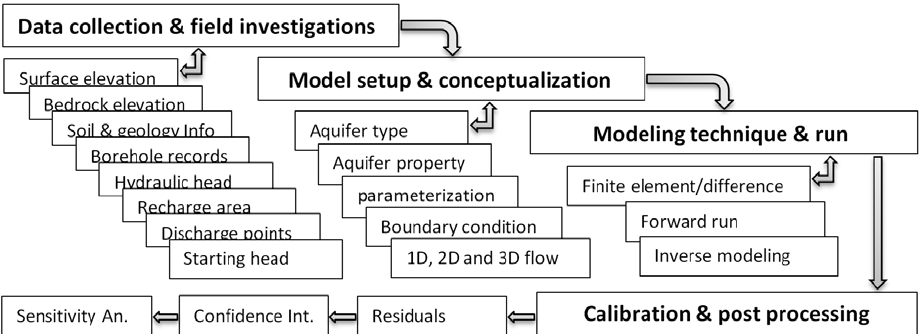
Fig. 3 . Flow chart of a mathematical groundwater model. Fig. 3. Flow chart of a mathematical groundwater model.